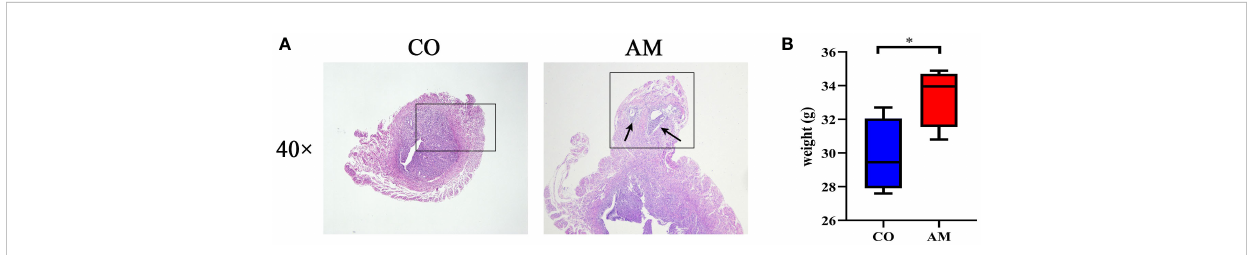
FIGURE 1 HE staining and body weight changes of mice in control and AM groups. (A) HE staining of transverse uterine sections in control group (left) and AM group (right). (B) Changes in body weight of mice after modeling (n=8 per group). CO, control group, AM, AM group. * P